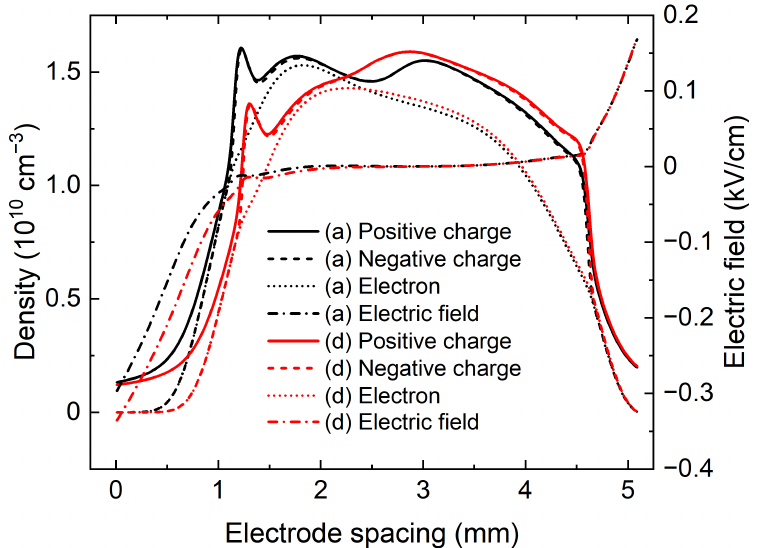
Figure 9. Spatial distributions of positive charge density, negative charge density, electron density, and electric field at the beginning of the positive discharge in RP2 discharge with a gap width of 5.1